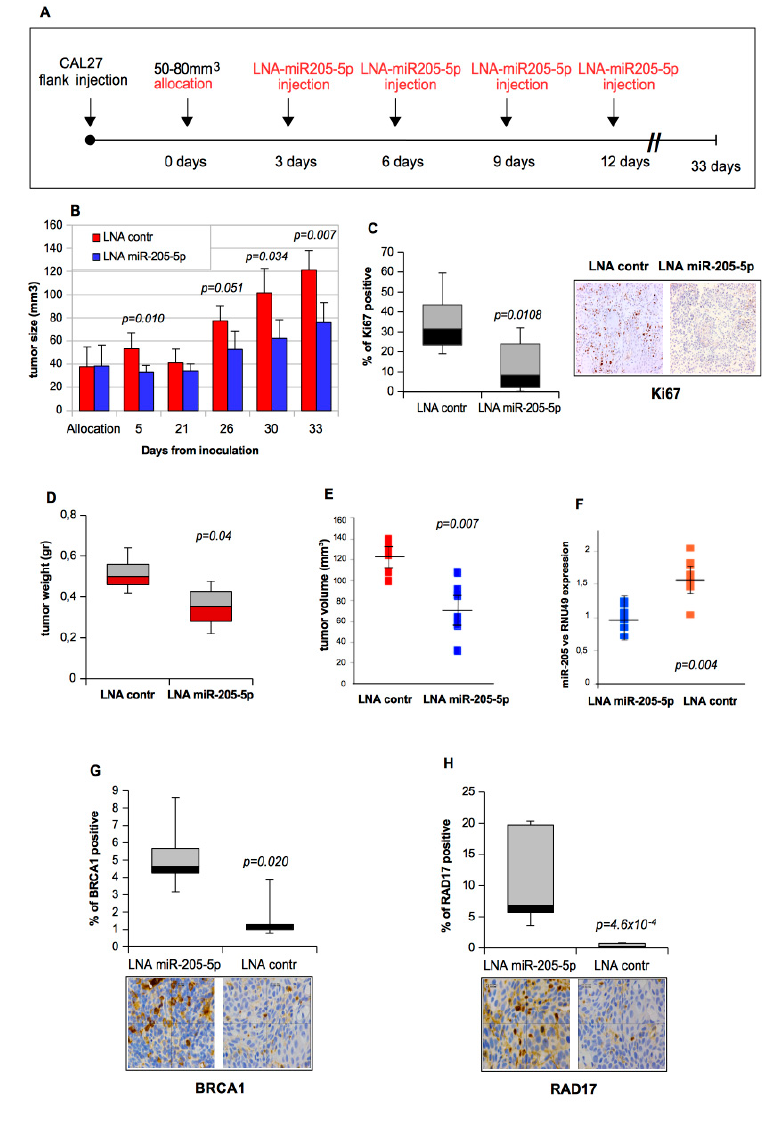
Figure 5. Intratumoral injections of miR-205-5p inhibitor downsize established HNSCC xenografts. ( A ) Schematic overview of in vivo experiments performed on orthotopic HNSCC. The tumor growth was monitored with the aid of a caliper. Mice assigned to the treatment and control groups were treated three times with miR-205-5p inhibitors or corresponding control oligonucleotides every three days; N = 6 mice in each group. In each panel, p -values were calculated by a two-sample t- test. Significant results are marked by a p -value <0.05 (*). ( B ) A total of 10 6 CAL27 cells in 30% matrigel were subcutaneously injected into immunodeficient Balb/C mice. On days 3, 6, 9, and 12 following mice allocation, synthetic LNA miR-205-5p inhibitor or control miRNAs conjugated with the Invivofectamine® 3.0 transfection reagent were intratumorally delivered into groups of six animals. Caliper measurements were taken to determine the length and width of each tumor and to calculate total tumor volumes. ( C ) Immunohistochemical analysis of Ki67 protein expression was analyzed in six LNA control- and LNA miR-205-5p-treated mice. Representative images and the relative quantification of ki67 positive cells are shown. ( D ) Tumor weight of the excised tumors measured at the end of the experiment. ( E ) Tumor volumes measured at the end of the experiment. ( F ) Relative miR-205-5p expression in CAL27 tumors. Total RNA was extracted from tumors harvested at the end of the experiment, and RT-qPCR was performed using a specific probe for miR-205-5p (Taq-Man assay). The normalization was carried out using RNU49 throughout the standard curve method. The p -values were calculated by a two-sample t- test; significant results are marked by a p -value < 0.05. (G and H) Immunohistochemistry on tumors treated with LNA control and LNA miR-205-5p. Sections from each mouse were incubated with an anti-BRCA1 antibody ( G ) and anti-RAD17 antibody ( H ). Representative fields are